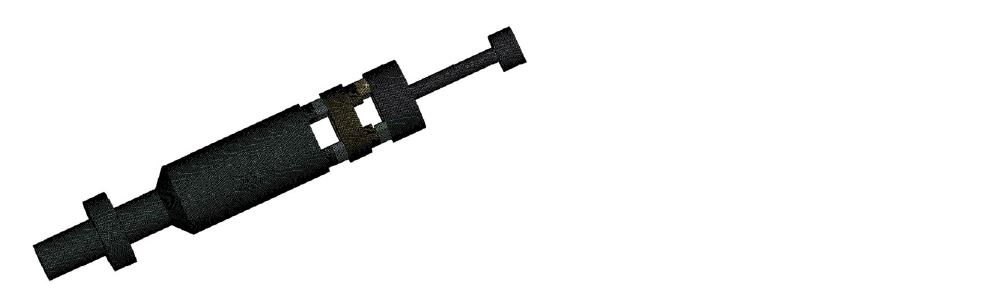
Figure 10. The mesh diagram of the 3D